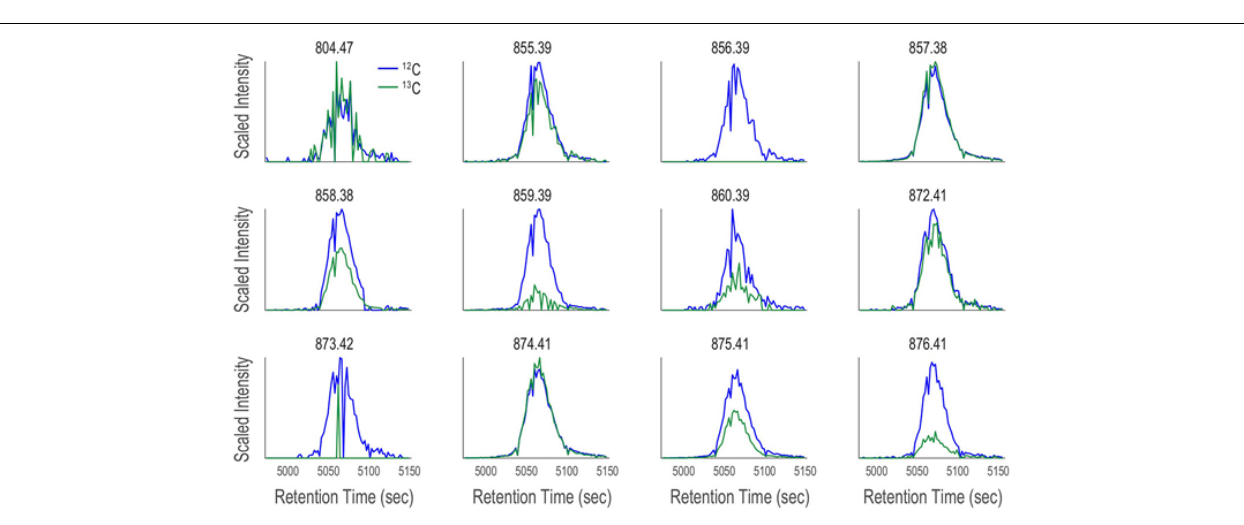
FIGURE 7 | Twelve target ions discovered by CMA-T that elute within T w = 4973–5153 s in the SPE organic extract of V. cyclitrophicus strain 1F-53 culture media after addition of iron. The EIC of each target ion (M; blue traces) is overlaid with the EIC of (M+1.003; green traces), after scaling the latter by the relative abundance of 13 C calculated according to Figure 8 , under the assumption of a singly charged ion and 50% carbon